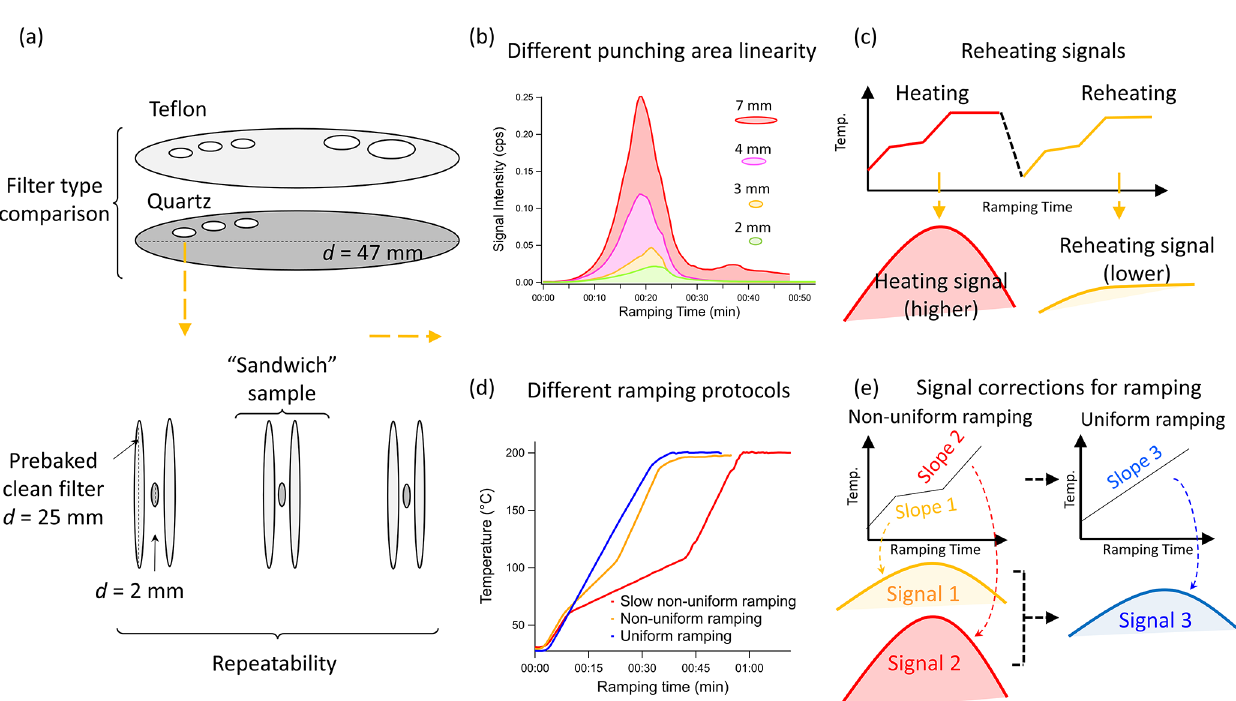
Figure 1. Schematic of the tests conducted in this study. (a) Sample preparation using punching areas of different sizes of the Teflon and quartz fiber filters and squeezing them between two original-sized filters for analysis. (b) Signal intensities of different punching areas from the same sample with the same analytical procedure. (c) Reheating tests by conducting two consecutive heating cycles. (d) Different temperature procedures. (e) Signal intensity correction from non-uniform ramping to uniform